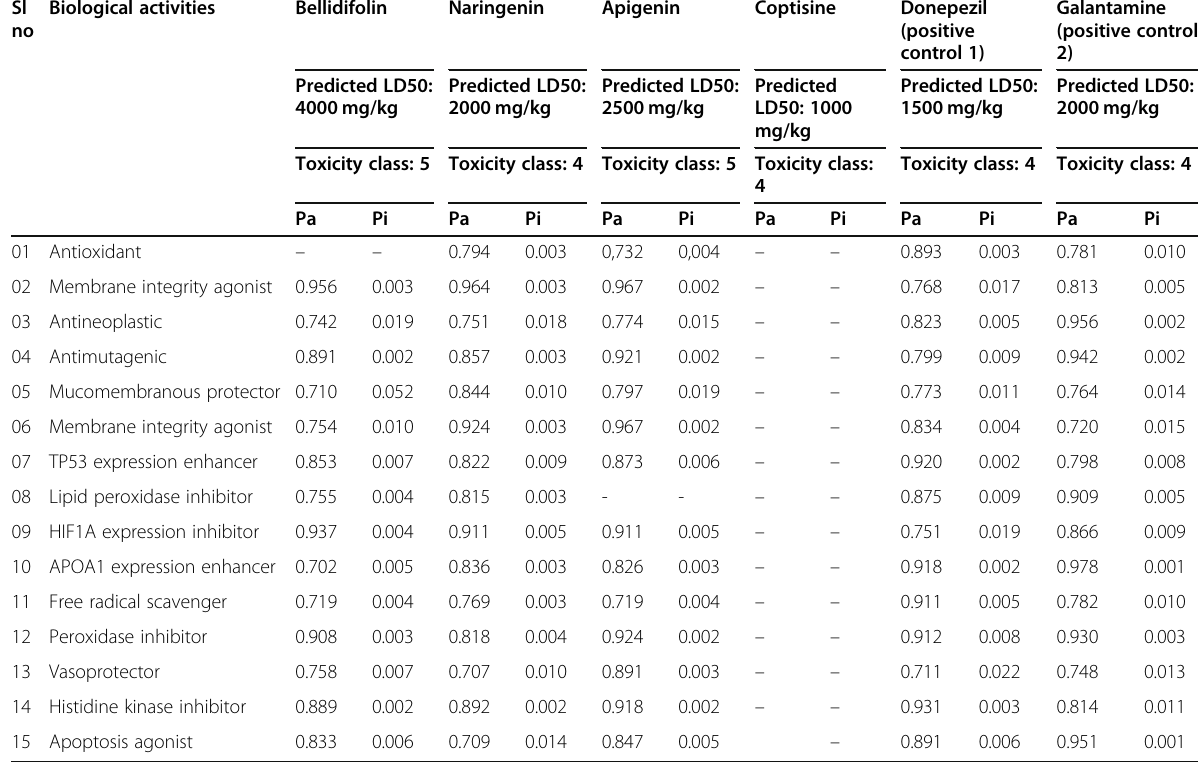
Table 7 The PASS prediction results showing the biological activities of the best 4 ligands and the positive controls Sl Biological no